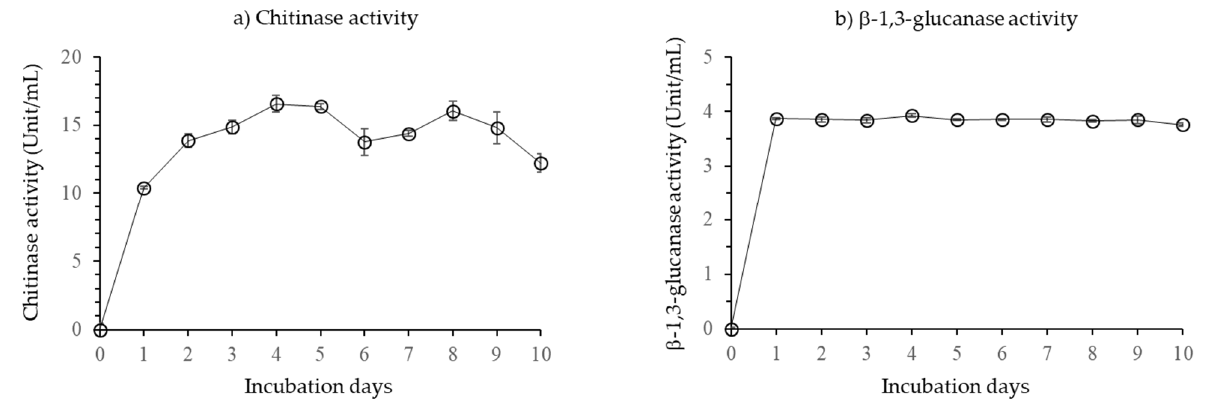
Figure 2. Changes in the activity of chitinase ( a ) and β -1,3-glucanase ( b ) secreted by Bacillus velezensis CE 100 during the incubation period. Error bars represent the standard deviation ( n = 3).